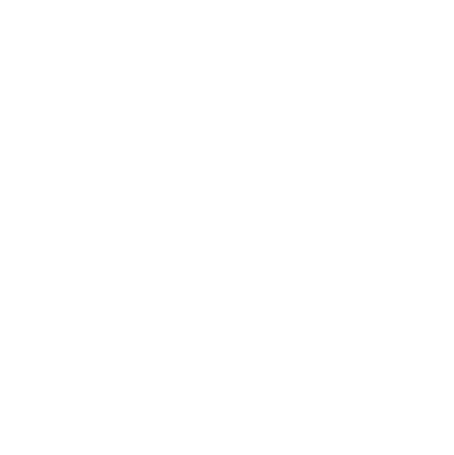
Figure 4. FL emission spectra of DSP crystals during the O → G → RO